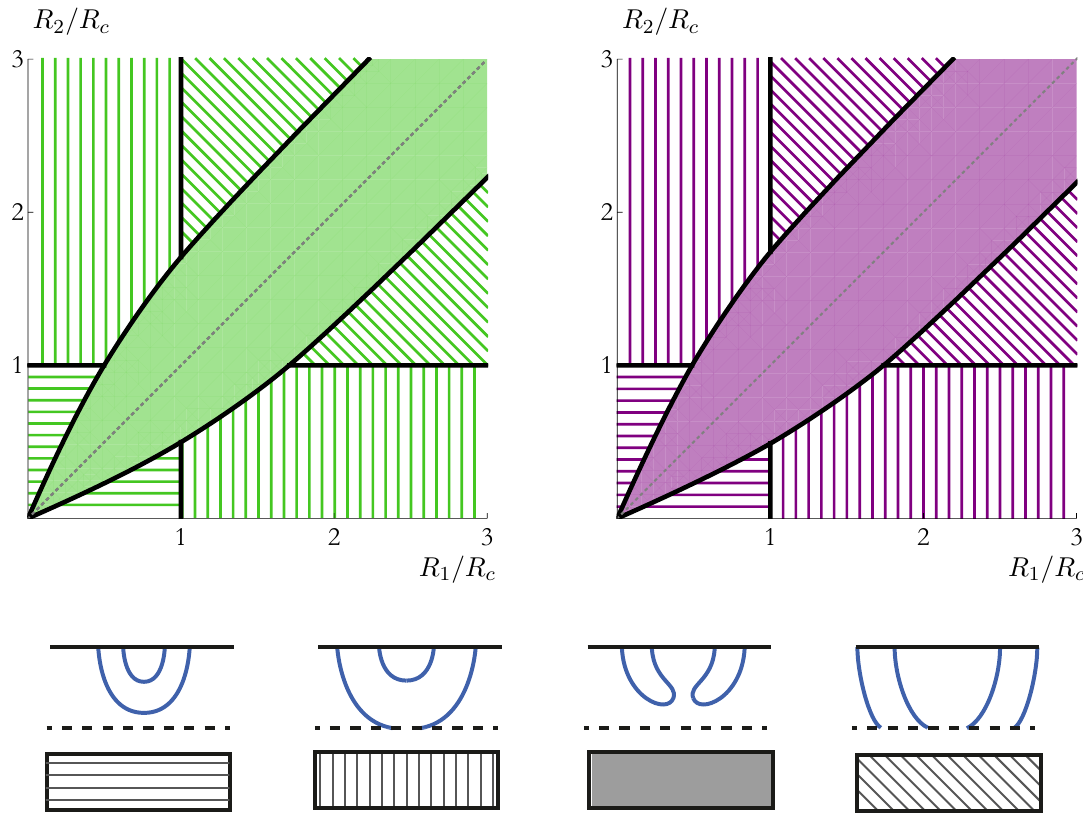
Figure 9. Phase diagram stemming from the analysis of mutual information of entanglement entropy of disks in the gapped non-confining theory B 0